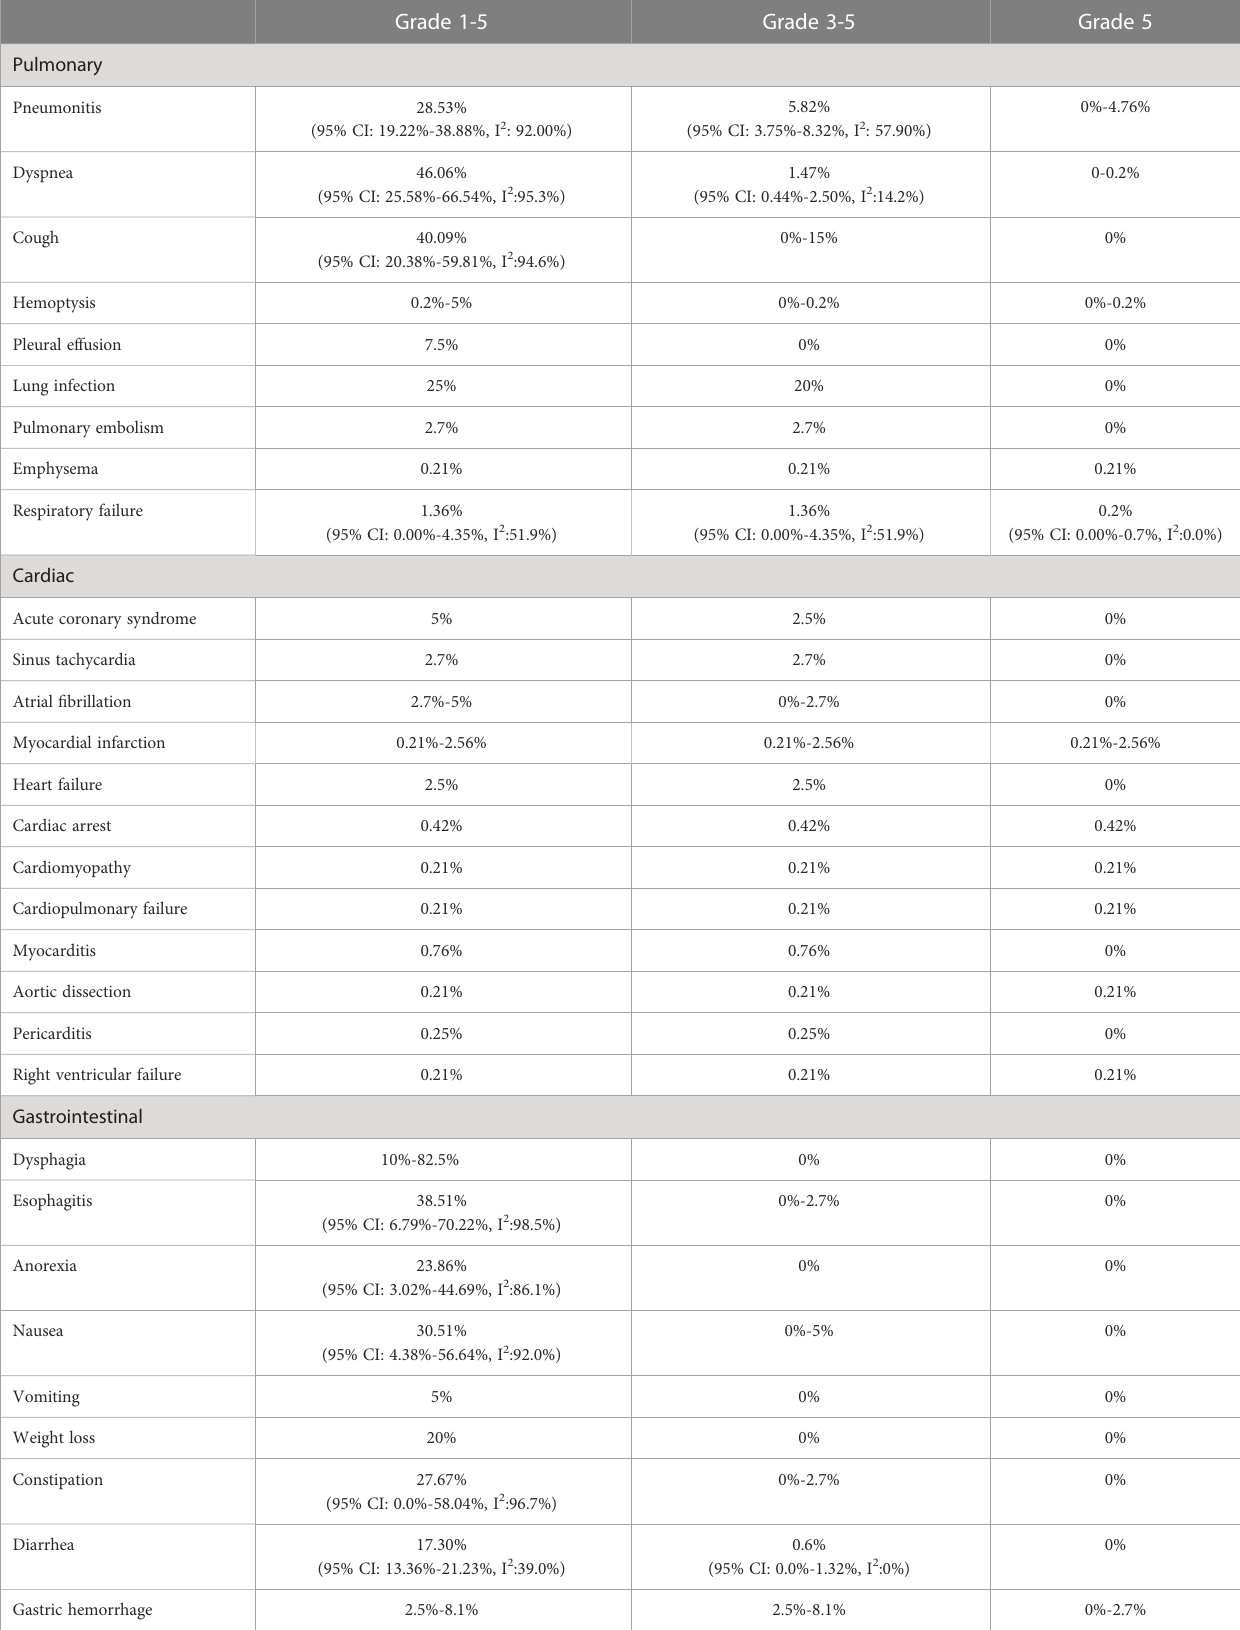
TABLE 3 Adverse events experienced by non-small cell lung cancer patients following treatment with ICIs and